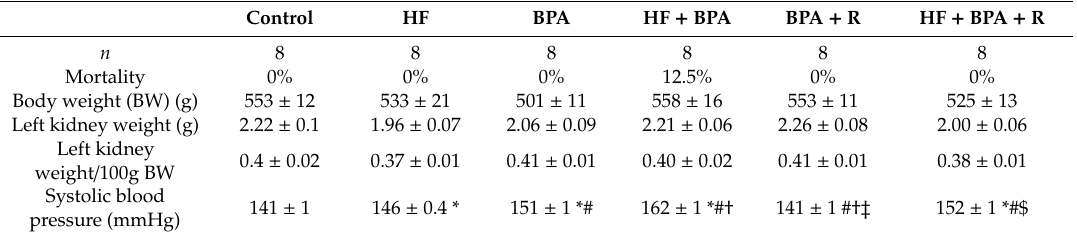
Table 1. Morphological values and blood pressures in di ff erent experimental groups.